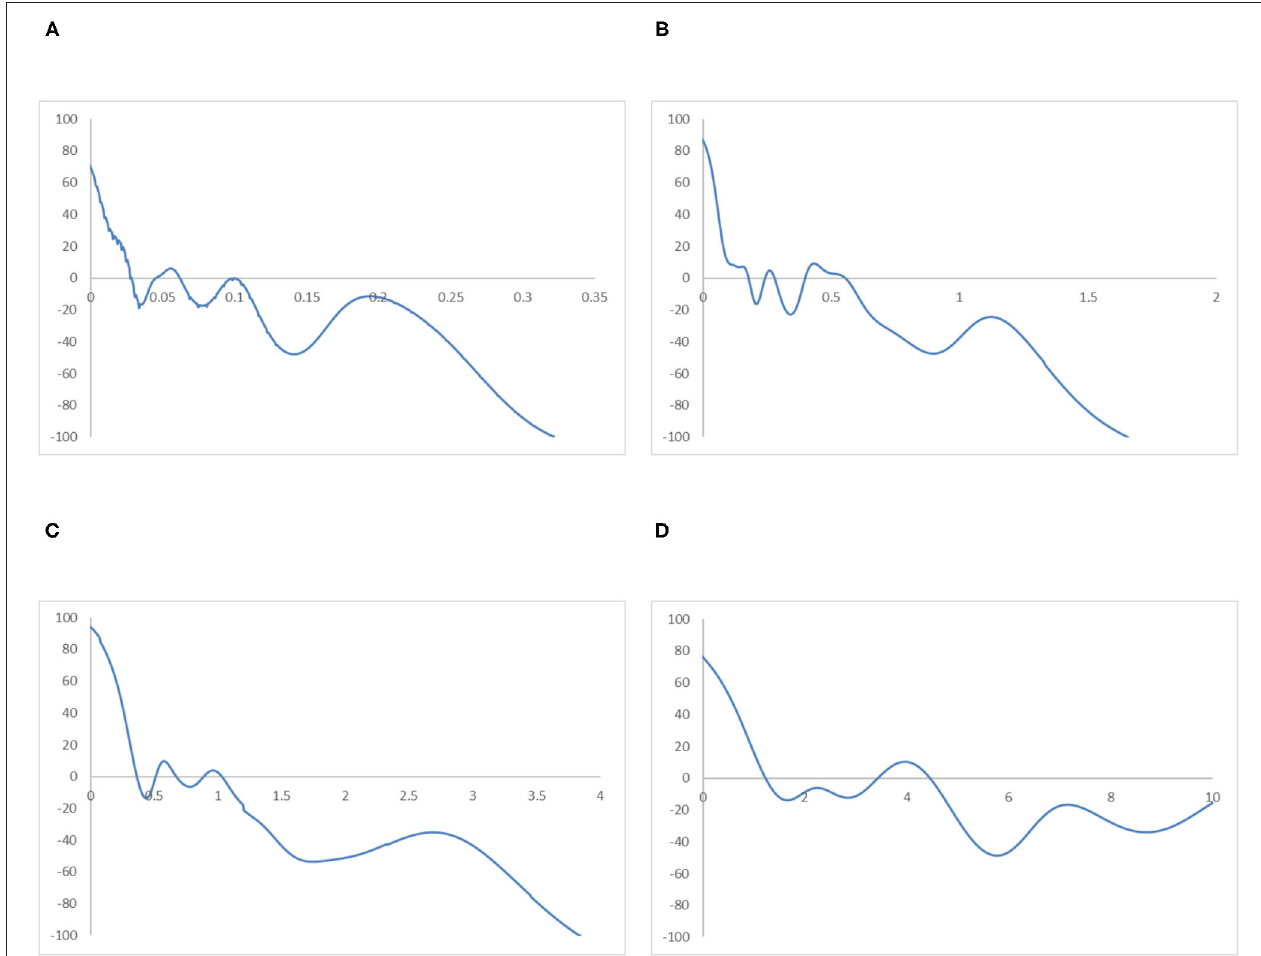
FIGURE 10 | Mobility probability plot (MPP) for the RIVAPC of countries for different income groups of countries. Source: authors’ calculation. N.B. The vertical axis indicates net upward mobility (%) and the horizontal axis indicates RIVAPC values. (A) Low-Income Countries. (B) Lower-Middle Income Countries. (C) Upper-Middle Income Countries. (D) High-Income